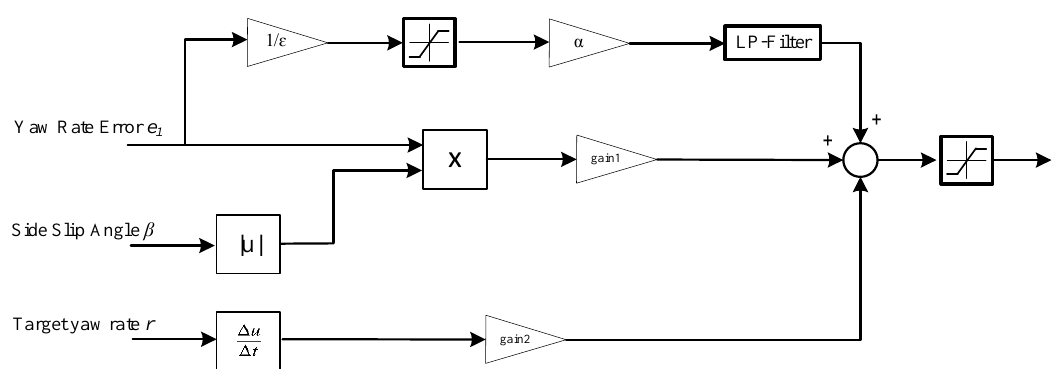
Figure 4. Sliding mode controller with a low-pass filter.